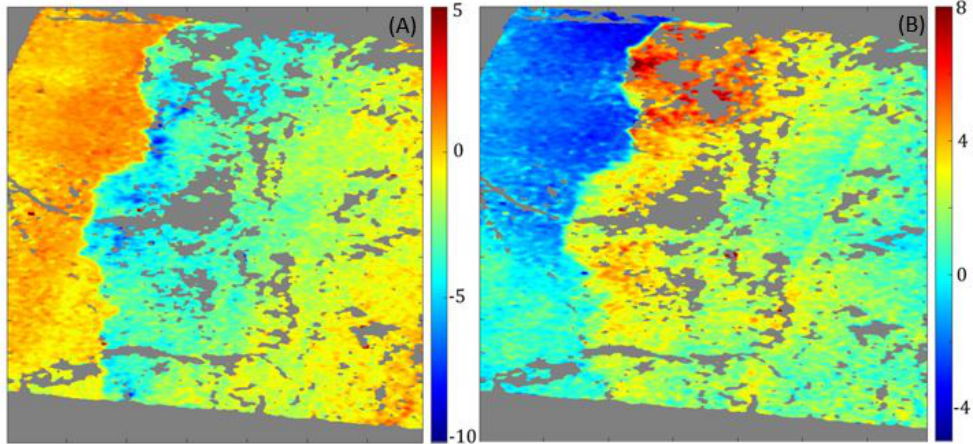
Figure 5. ( A , B ) East-West and North-South horizontal offsets obtained from the sub-pixel correlation of the two SPOT images (see Table 2) acquired before and after the earthquake (scale in m). Grey areas are where the correlation was too low. (Mean and standard deviation for EW band: − 1.5 m, 1.7 m and for NS band: 1.2 m, 1.9